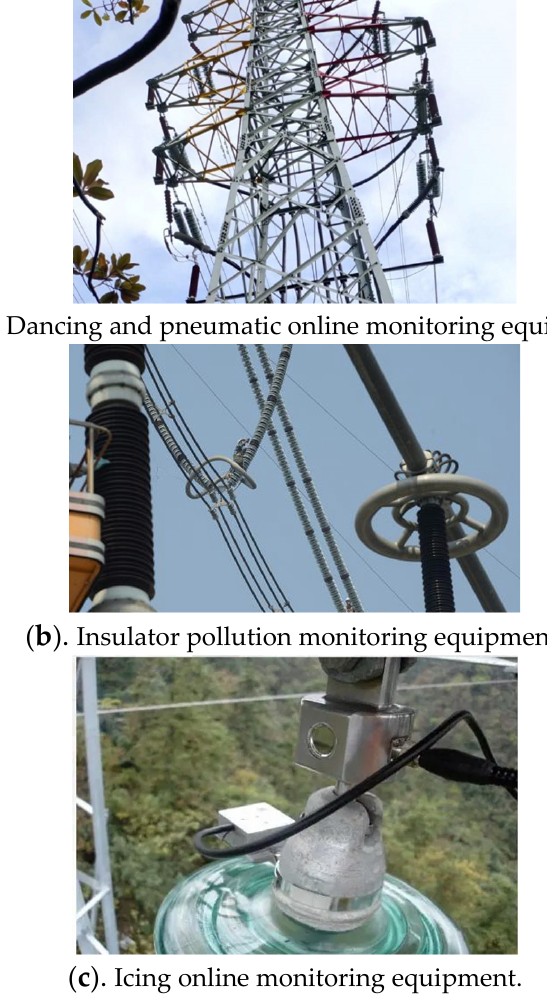
Figure 18. Common high-voltage transmission line online monitoring equipment.